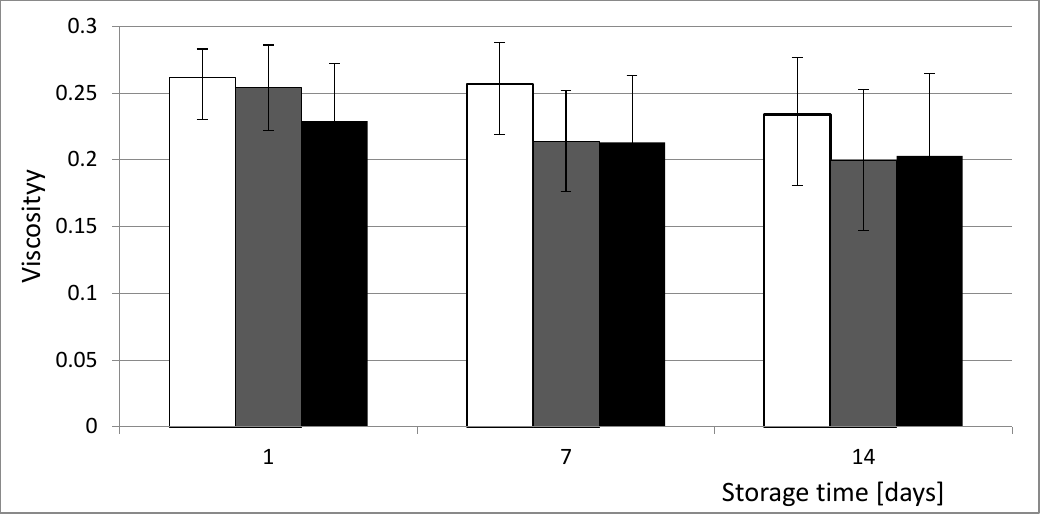
Figure 2. Viscosity of yoghurts supplemented with Rosa spinosissima fruits extract during 14 days of